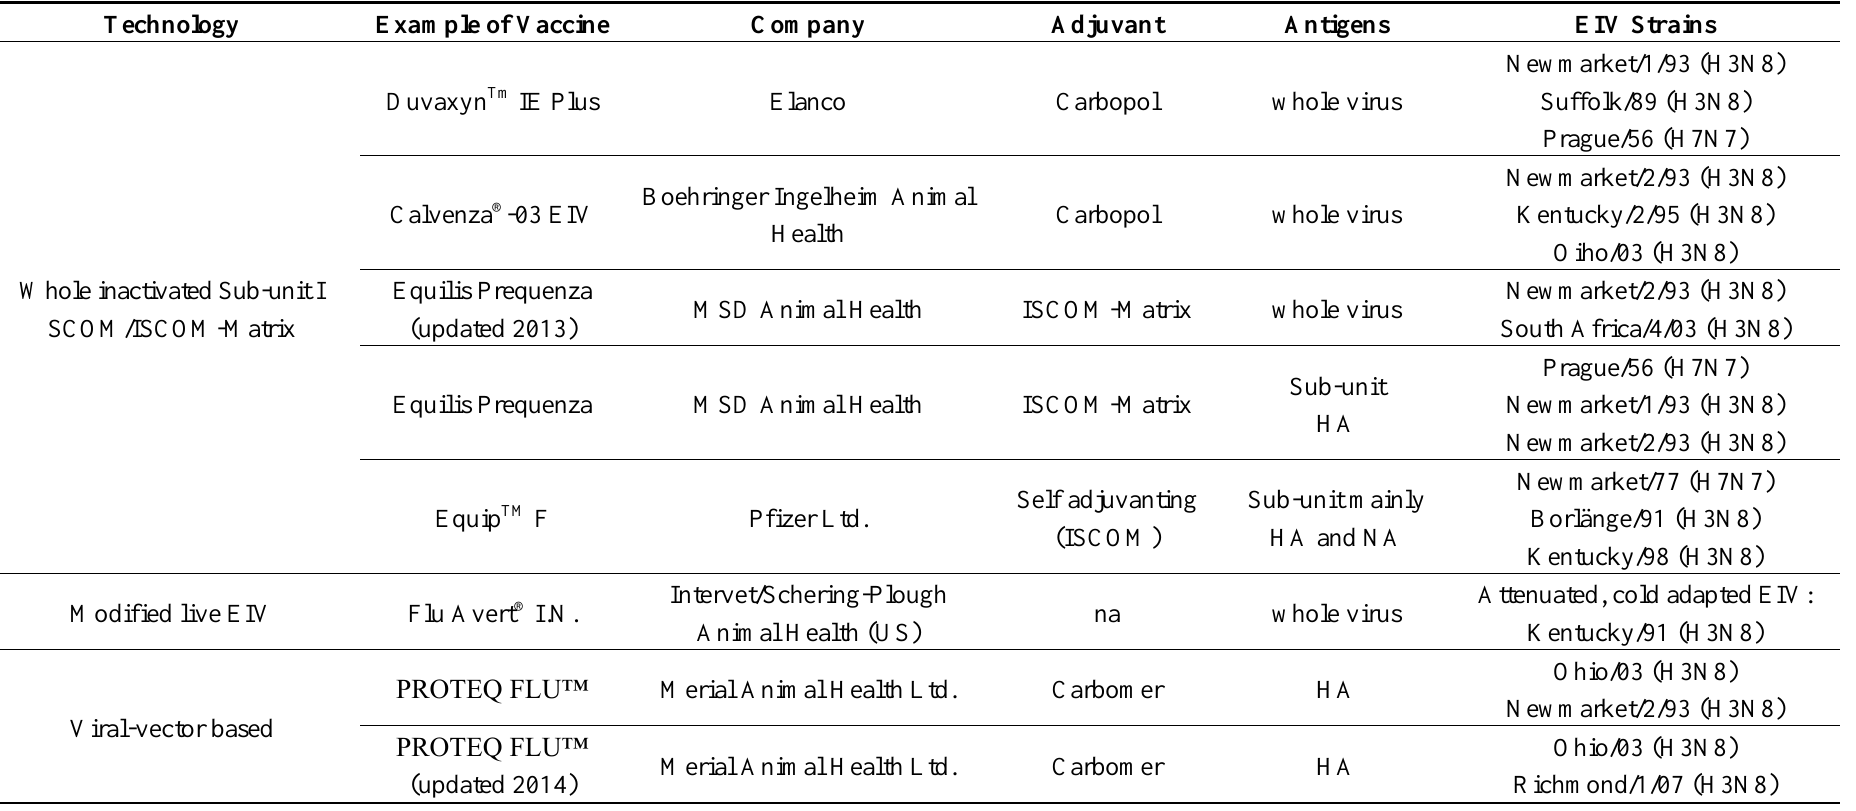
Table 1. Examples of commercial EI vaccines, classed by technologies. Several of these vaccines are commercialised as EIV vaccine alone or in combination with Tetanus (such combination will be reflected in the name of the vaccine, e.g., Duxaxyn IE-T